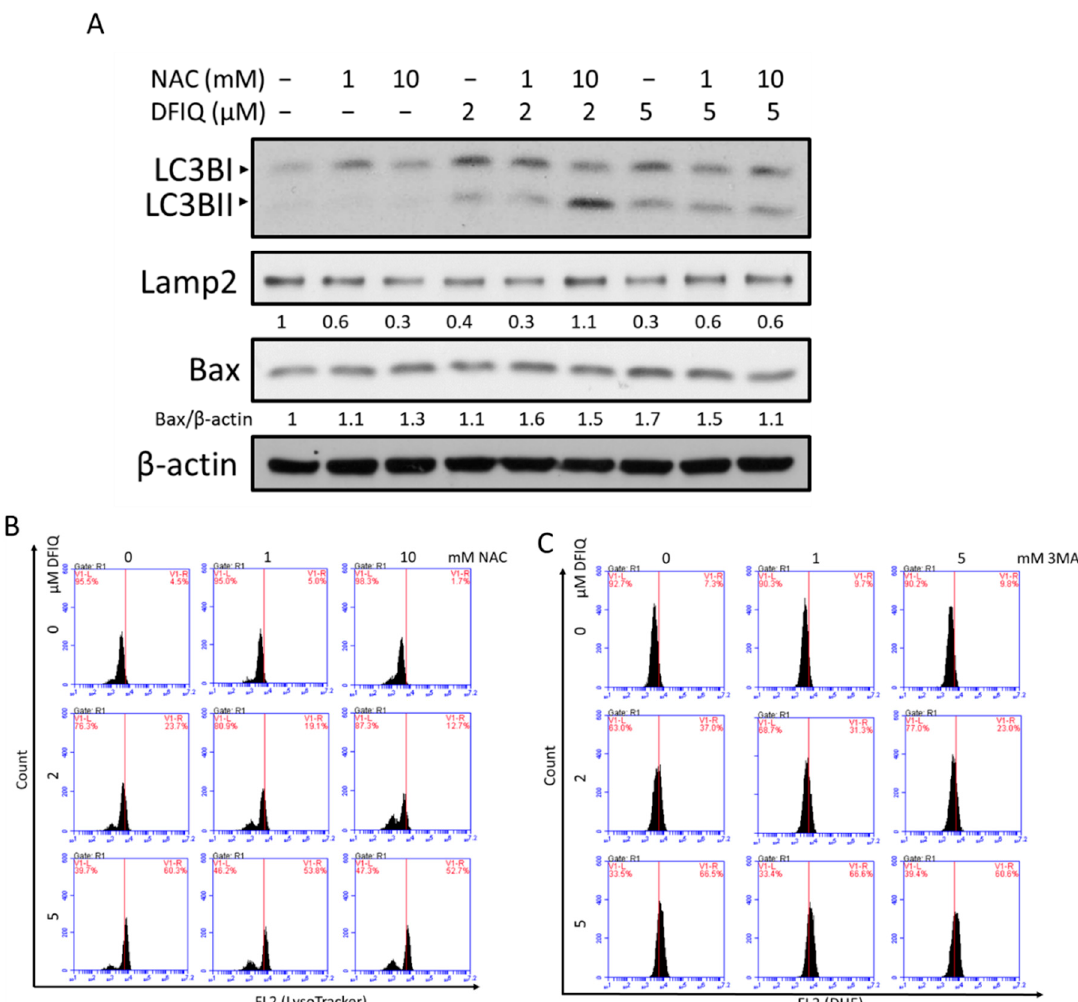
Figure 5. Crosstalk between autophagy and ROS during DFIQ treatment. ( A ) Western blot analysis of the expression of autophagic and apoptotic proteins after DFIQ treatment for 6 h. ( B ) Lysosome accumulation after cotreatment with DFIQ and NAC for 6 h. ( C ) Superoxide formation after cotreatment with DFIQ and the autophagy inhibitor 3-MA for 6 h. The uncropped blots and molecular weight markers of Figure 5A are shown in Figure